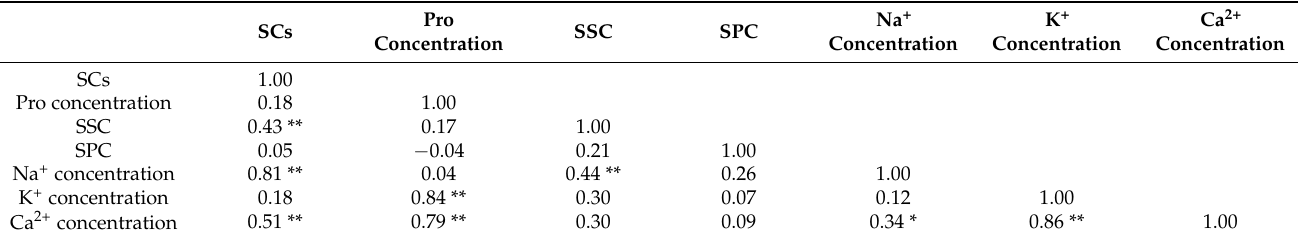
Table 5. Correlation analysis of salt concentrations with osmoregulation substances and ion concentrations in C. elegans seedlings. *, **: significant at the 0.05 and 0.01 probability levels, respectively, by the Pearson correlations. SCs, salt concentrations; Pro, proline; SSC, soluble sugar concentration; SPC, soluble protein concentration; Na + , sodium ions; K + , potassium ions; Ca 2+ , calcium